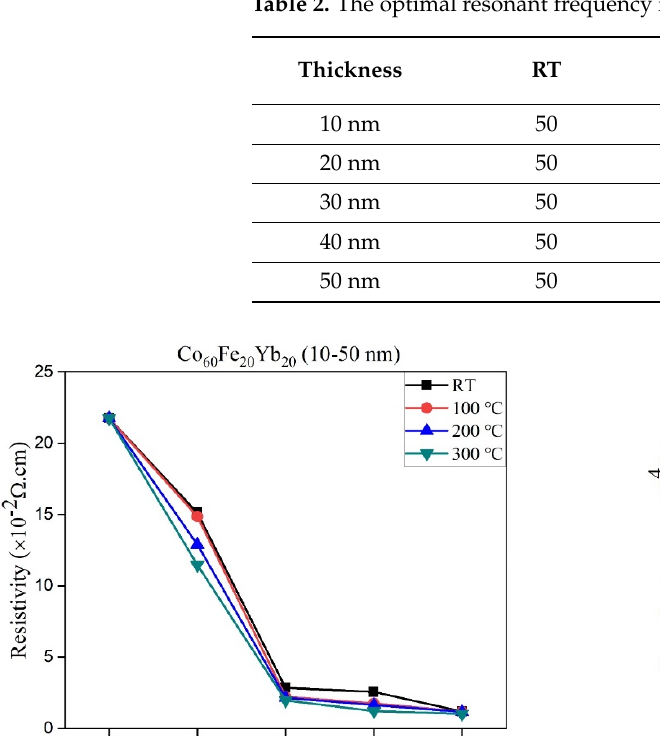
6 of 12 Figure 3. Maximum χ ac for the CoFeYb thin films. Table 2. The optimal resonant frequency for various thicknesses.